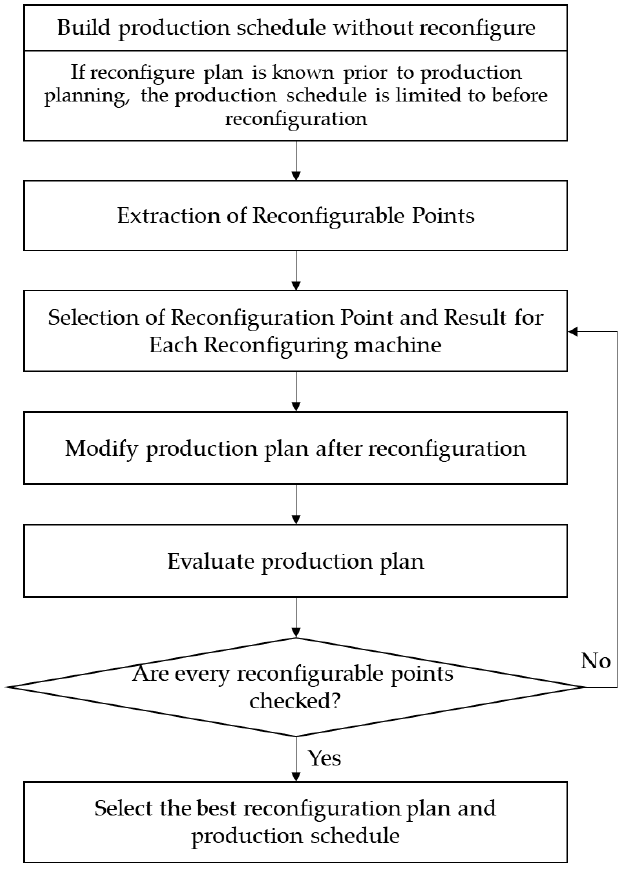
Figure 6. The reconfiguration planning process.